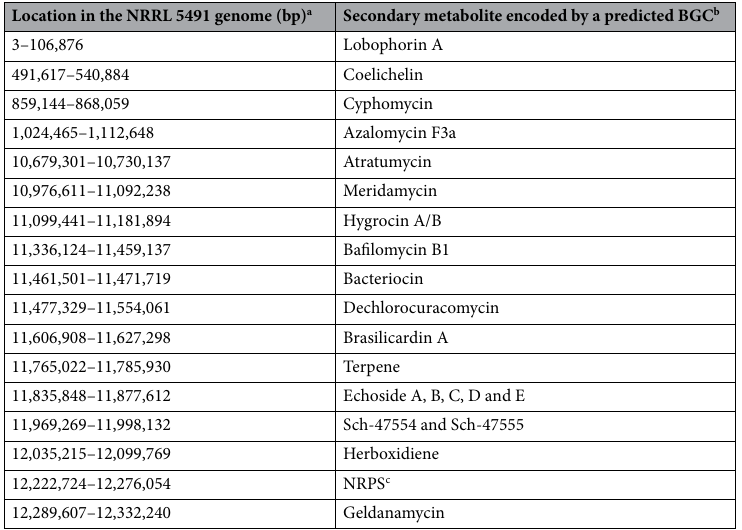
Table 1. Biosynthetic gene clusters (BGCs) that appeared to be absent in the SRMK07 strain’s genome. a BGCs were detected using antiSMASH version 5.0 27 . b Metabolites in red are polyketides or hybrids of non-ribosomal peptide and polyketide. c Non-ribosomal peptide